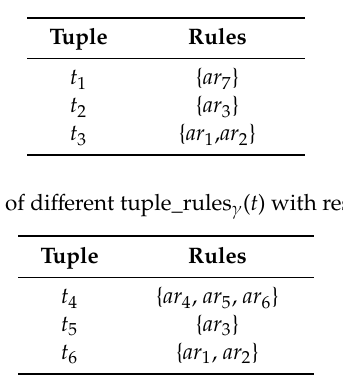
Table 13. Sets of di ff erent tuple_rules γ ( t ) with respect to sod 1 .